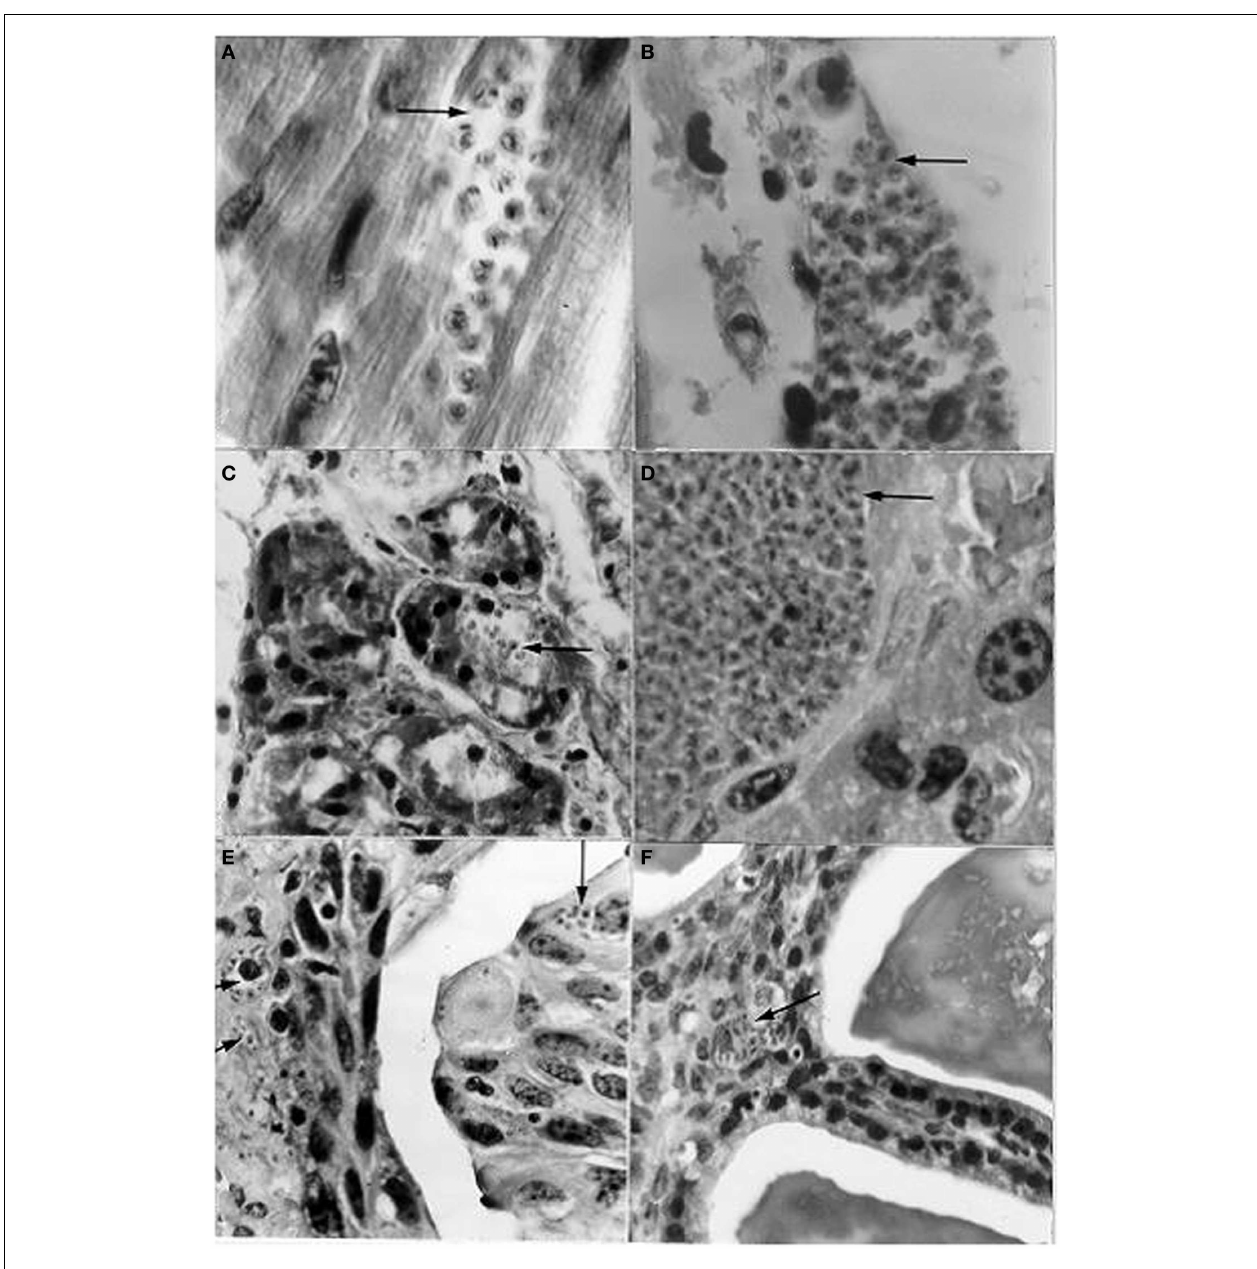
FIGURE 8 | Histological sections from albino mice intravaginally instilled with a strain of Trypanosoma cruzi from Rattus rattus , and scrotally inoculated with a strain from a human patient, showing nests (arrows) with amastigotes in (A) cardiac tissue;